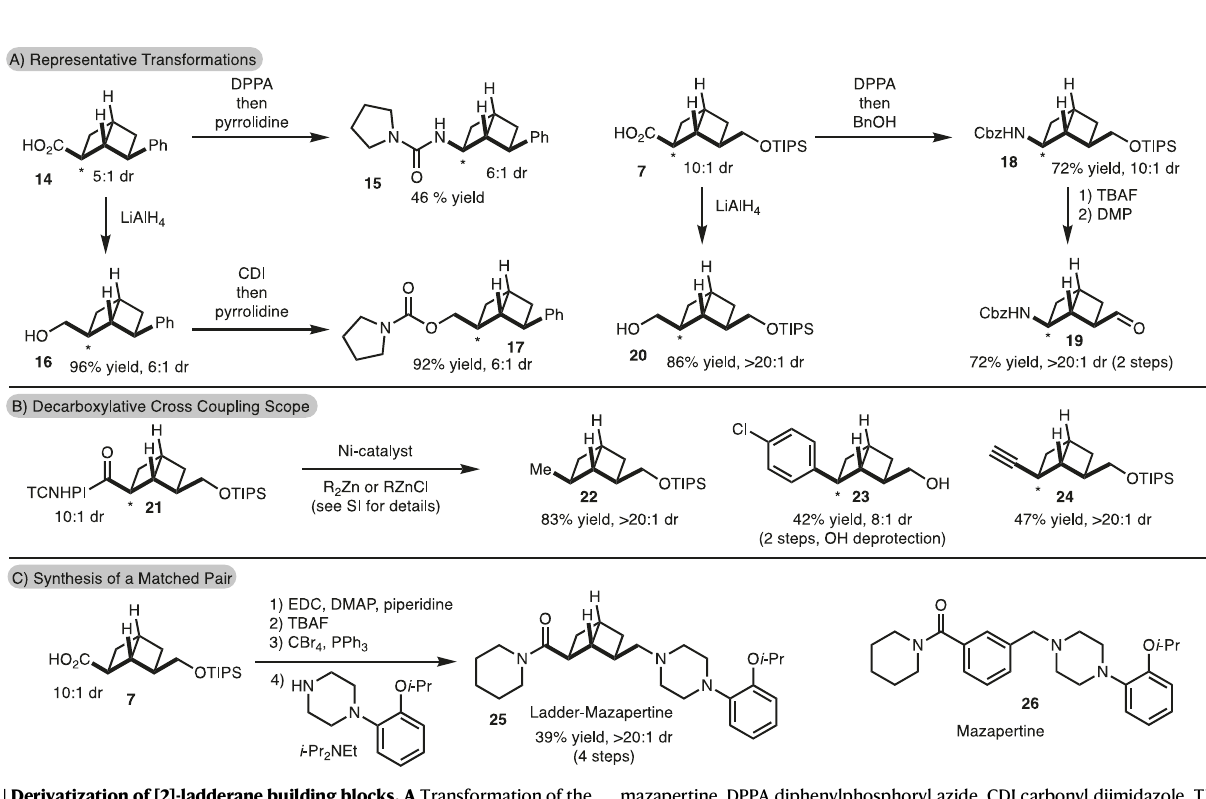
mazapertine. DPPA diphenylphosphoryl azide, CDI carbonyl diimidazole, TBAF tetrabutylammonium fl uoride, DMP Dess Martin periodinane, EDC 1-ethyl-3-(3-